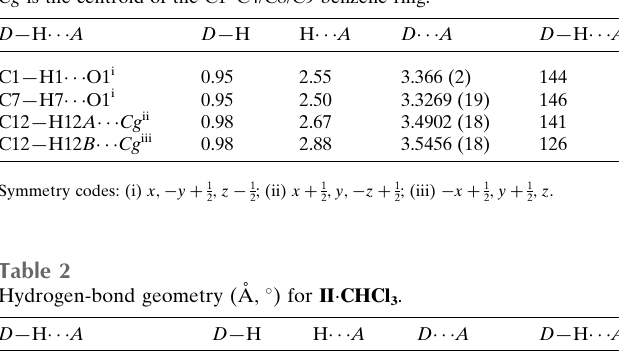
Table 3 Short interatomic contacts a (A˚ ) for I and II (cid:2) CHCl 3 . Atom1 Atom2 Length